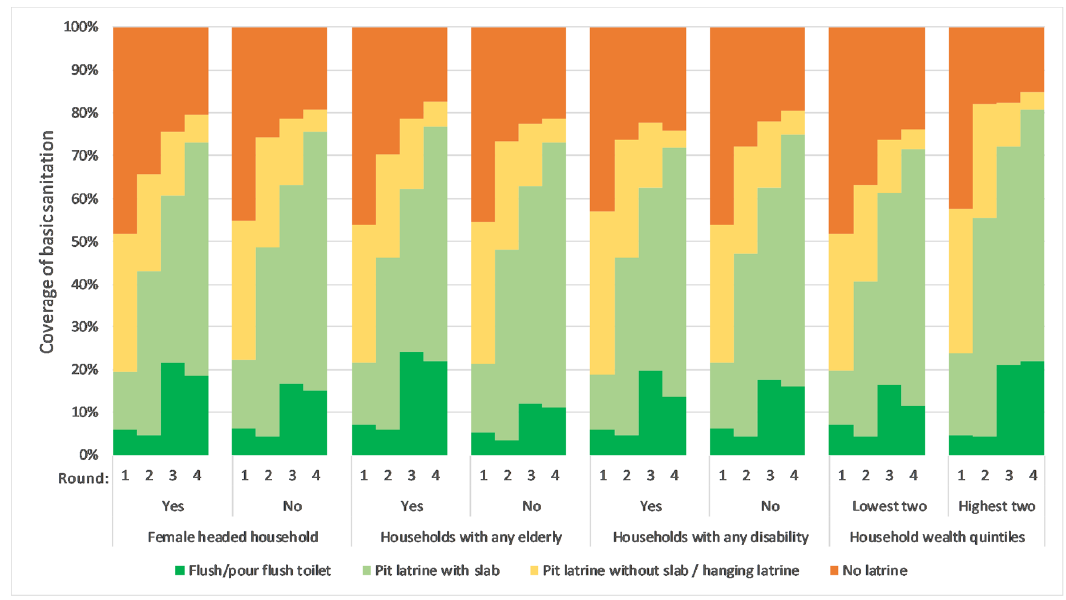
Figure 2. Equity in sanitation technologies over the four rounds, aggregated across all countries.